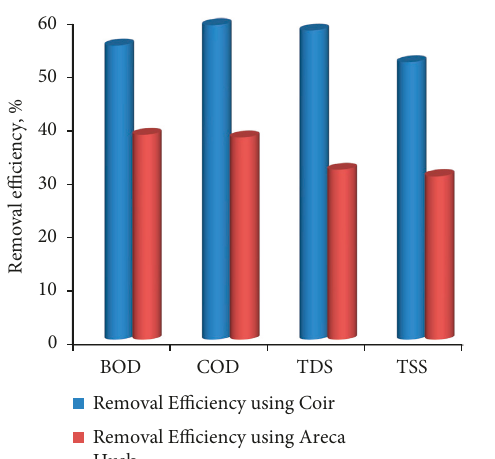
Figure 6: Effect of filter media (fibrous materials) types for the treatment of